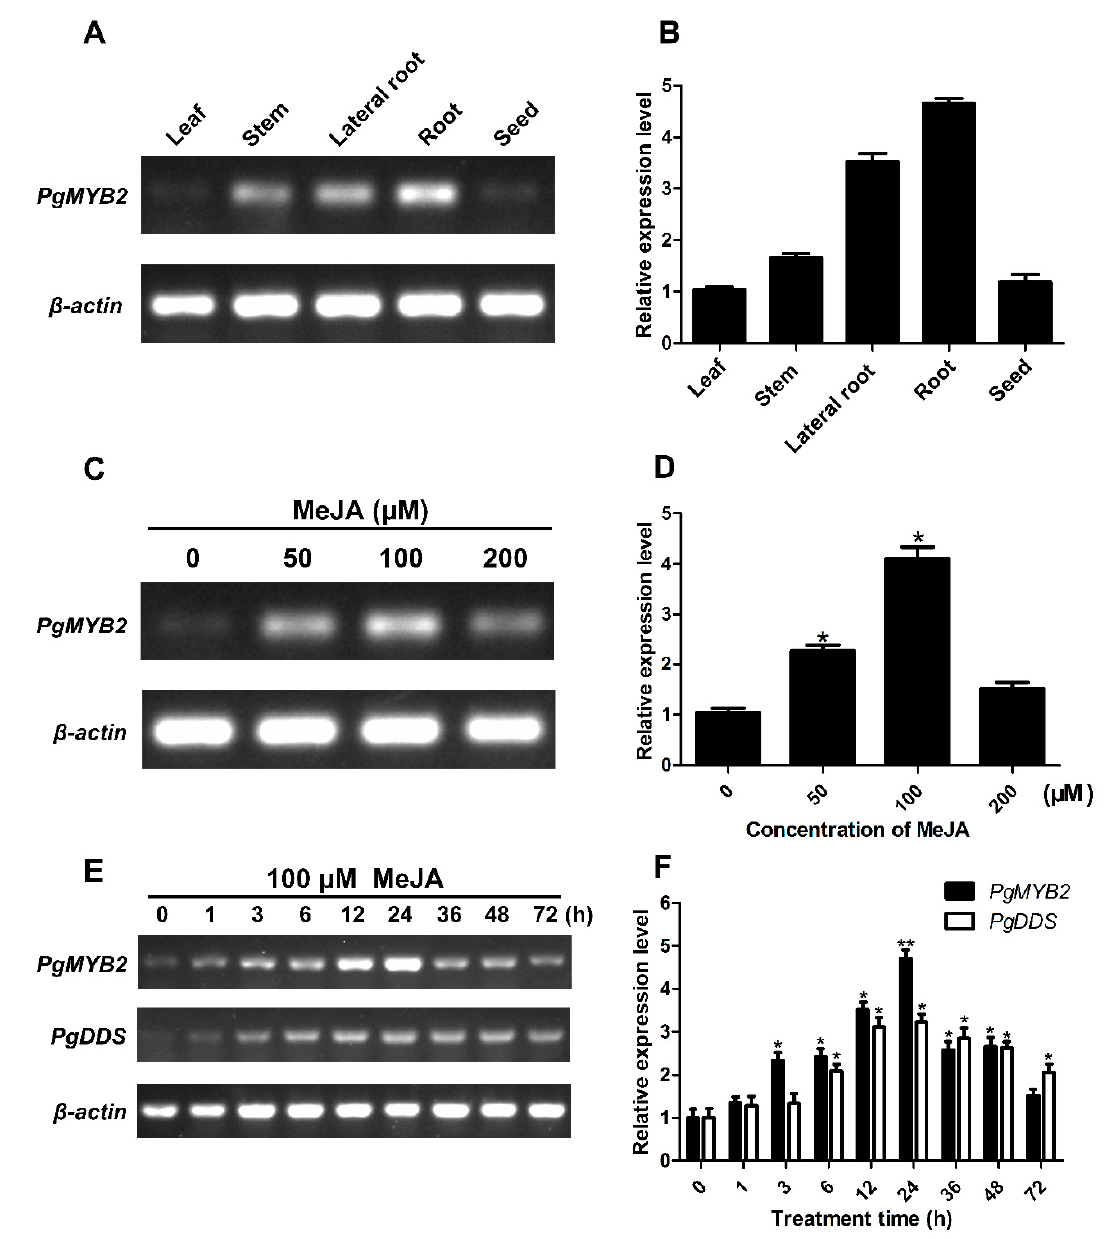
Figure 4. Expression analysis of PgMYB2 and PgDDS. RT-PCR ( A ) and qRT-PCR ( B ) analyzed the expression of PgMYB2 in di ff erent tissues. The relative expression level was calculated according to the expression of the corresponding gene in the leaves. RT-PCR ( C ) and qRT-PCR ( D ) analyzed the expression levels of PgMYB2 under di ff erent concentration of MeJA for 12 h. The relative expression level was calculated according to the expression of PgMYB2 at 0 µ M MeJA. RT-PCR ( E ) and qRT-PCR ( F ) analyzed the expression levels of PgMYB2 and PgDDS under the treatment of 100 µ M MeJA at di ff erent time points. The relative expression level was calculated according to the expression of PgMYB2 and PgDDS at 0 h. All expression levels were normalized according to the β -actin expression level. The standard deviations from three independent repeated trials were indicated by the error bars. Asterisks indicated a significant di ff erence by t -test, * p < 0.05, ** p <